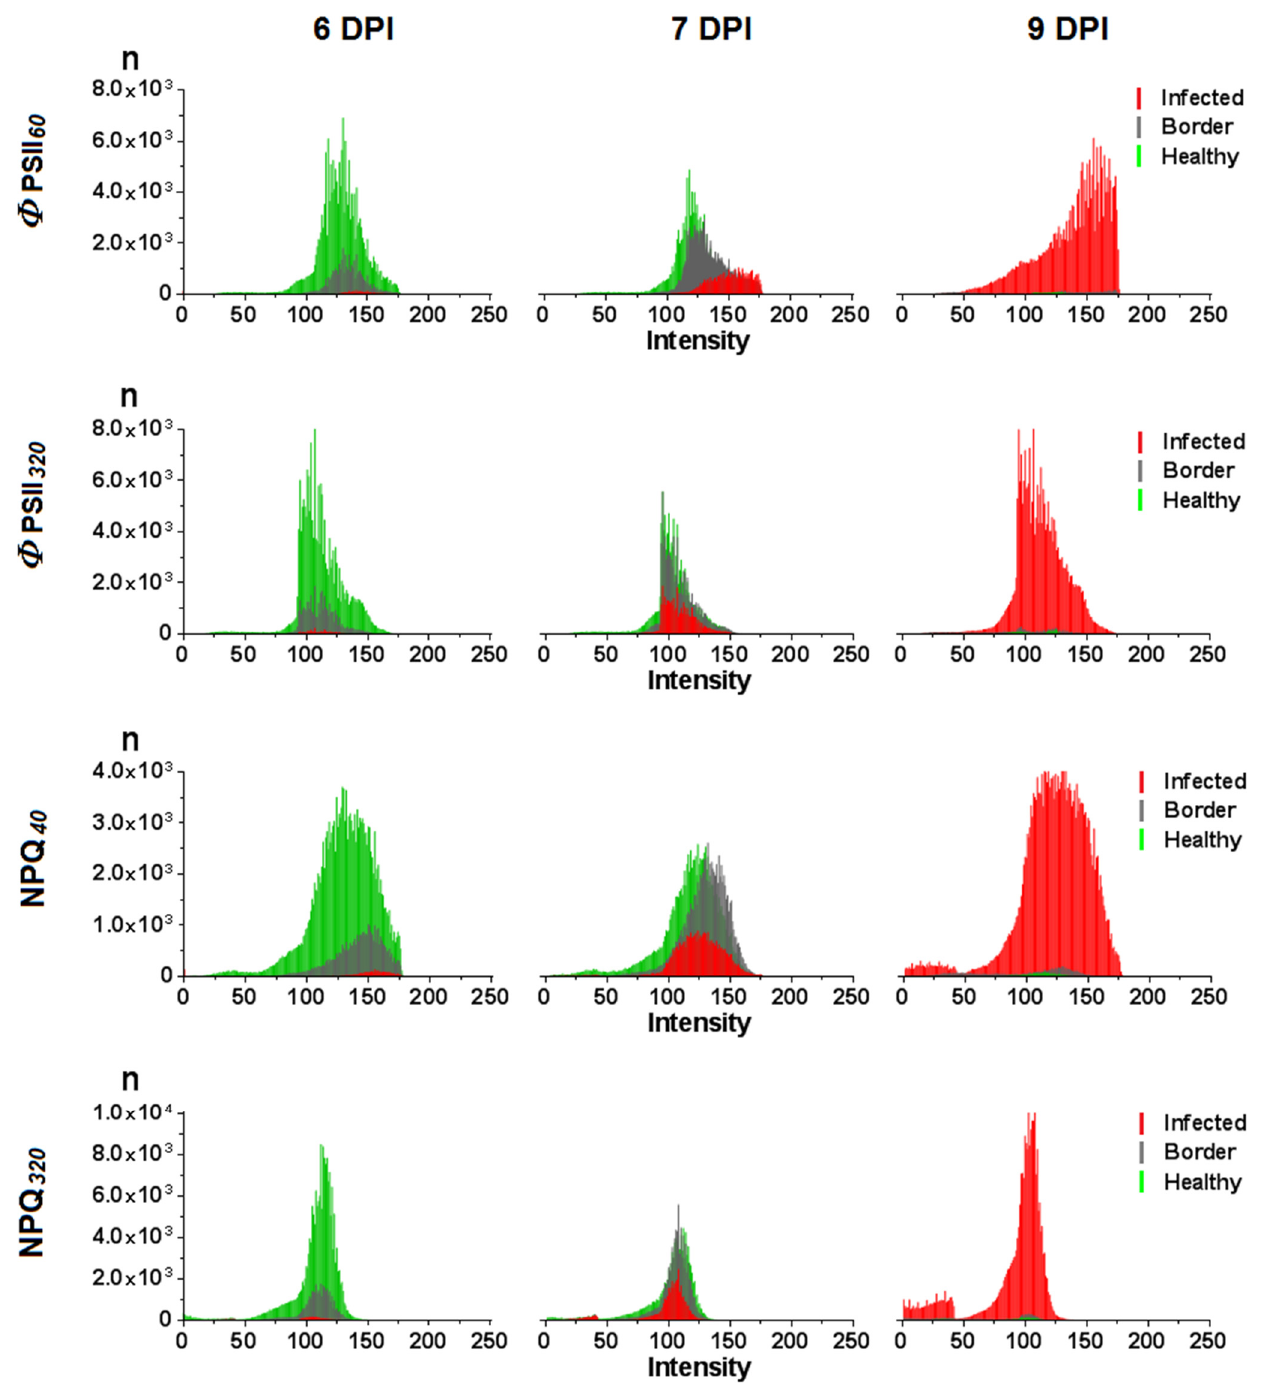
Figure 9. Histograms of the distribution of the intensity of the Φ PSII 60 and NPQ 40 signal in the infected, border, and healthy areas of the leaf at different days post-inoculation (DPI); 6 DPI corresponds to the first day of PVX-GFP detection in the studied leaf. Histograms of Φ PSII images obtained 60 and 320 s after the AL was switched on, and NPQ images obtained 40 and 320 s after the AL was switched on are shown. A representative example of a single plant is presented.